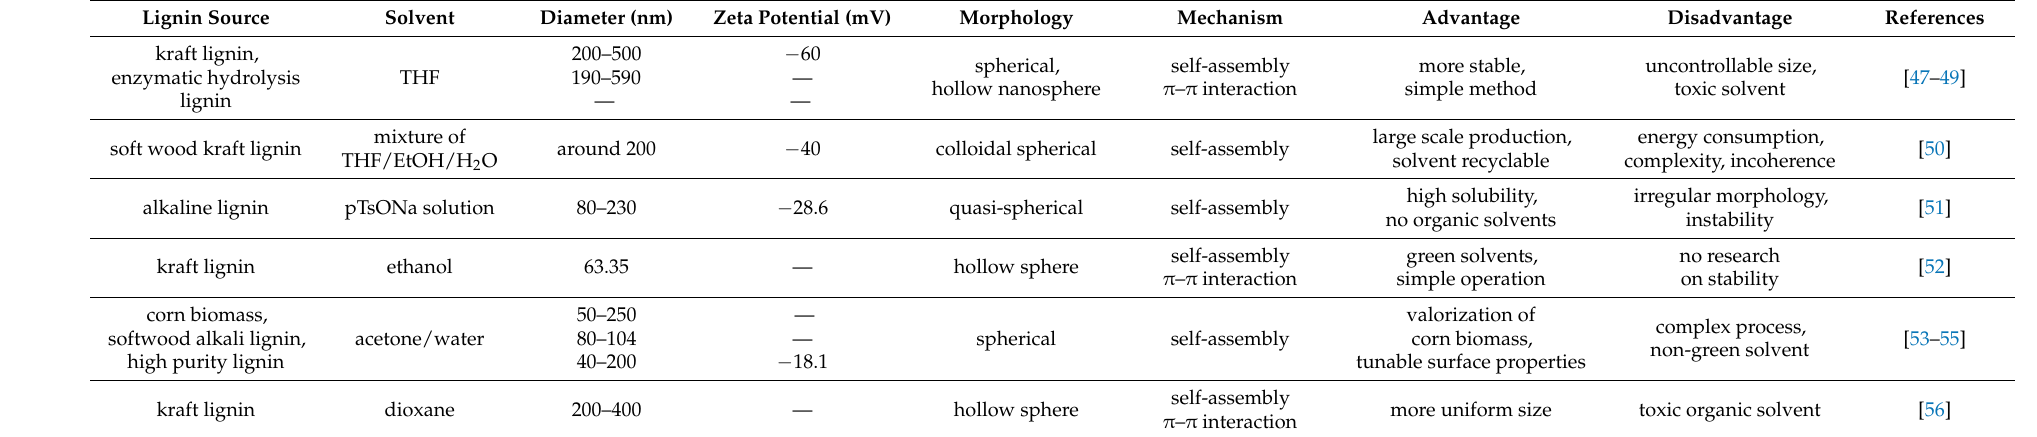
Table 1. Preparation of Lignin Nanoparticles by Using Water as Anti-solvent.